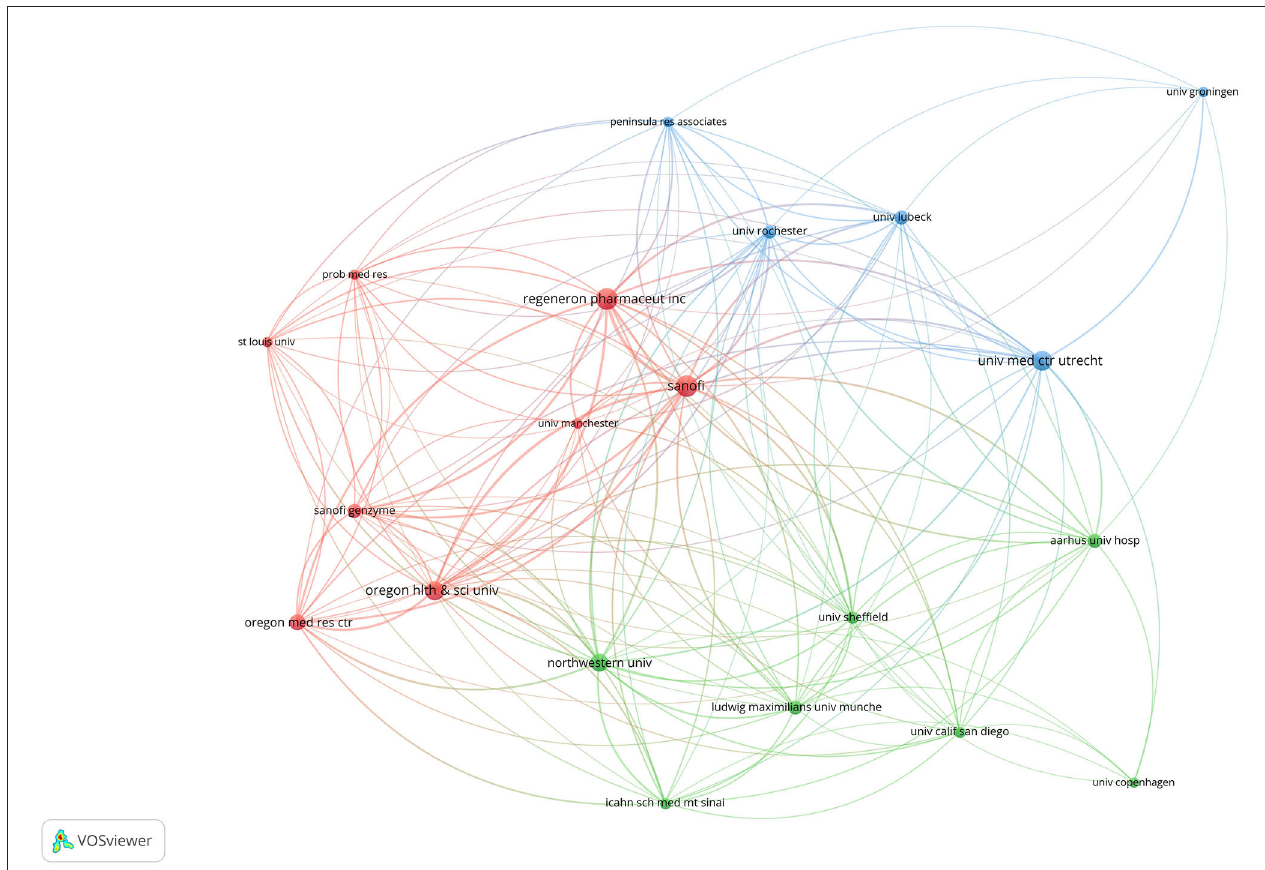
FIGURE 4 | The collaborative network of